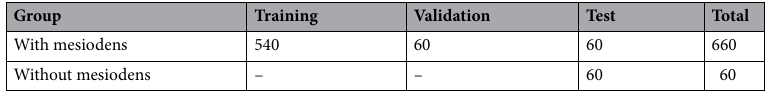
Table 1. Number of periapical radiographs in the training, validation, and test